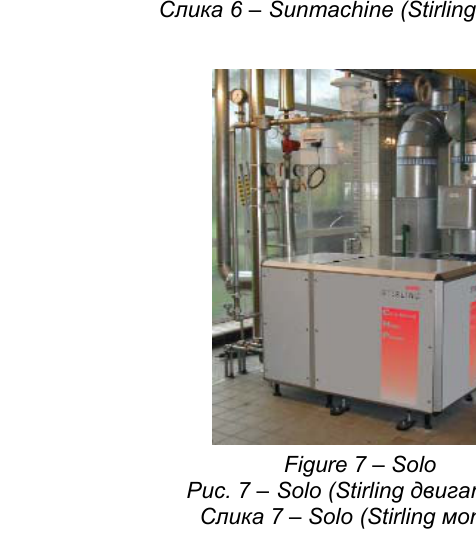
Рис . 6 – Sunmachine (Stirling двигатель ) Слика 6 – Sunmachine (Stirling мотор )